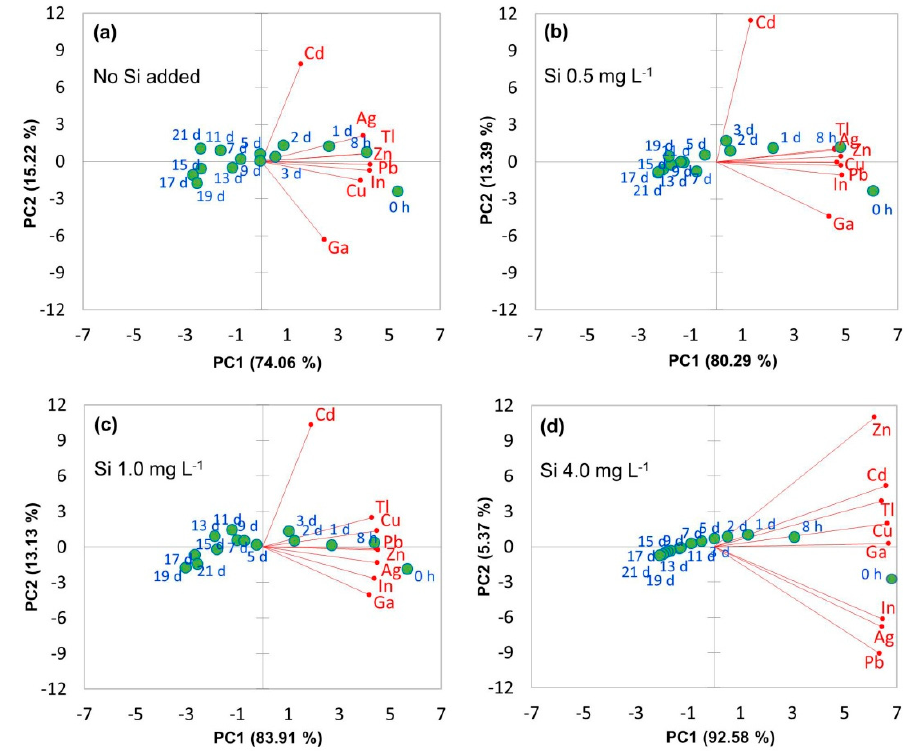
Figure 2. Score plots of principal component 1 (PC1) versus PC2 indicating the di ff erentiation of Figure 2 . Score plots of principal component 1 (PC1) versus PC2 indicating the differentiation of removal e ffi ciencies of heavy removal efficiencies of heavy metals.